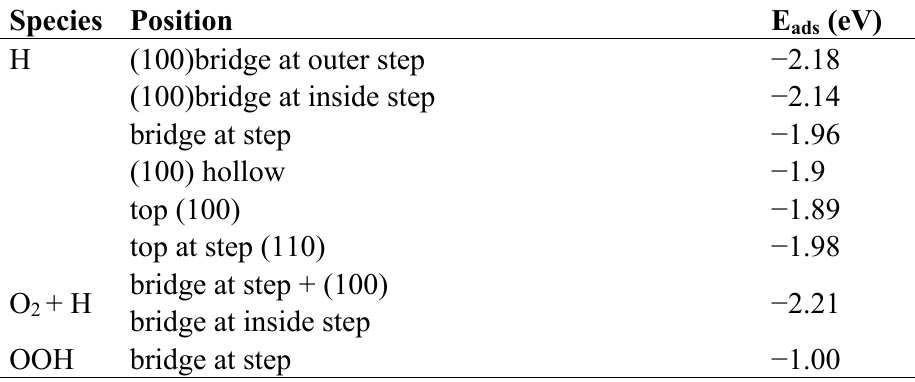
Table 1. Adsorption energy of different species on Au(310)-p(2 ×